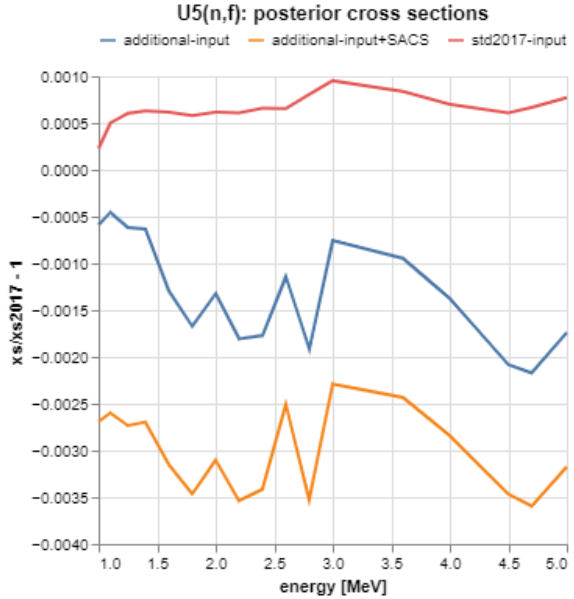
Figure 1: Evaluated 235 U(n,f) cross sections relative to the IAEA STD 2017 [3] from 1 MeV up to 5 MeV.